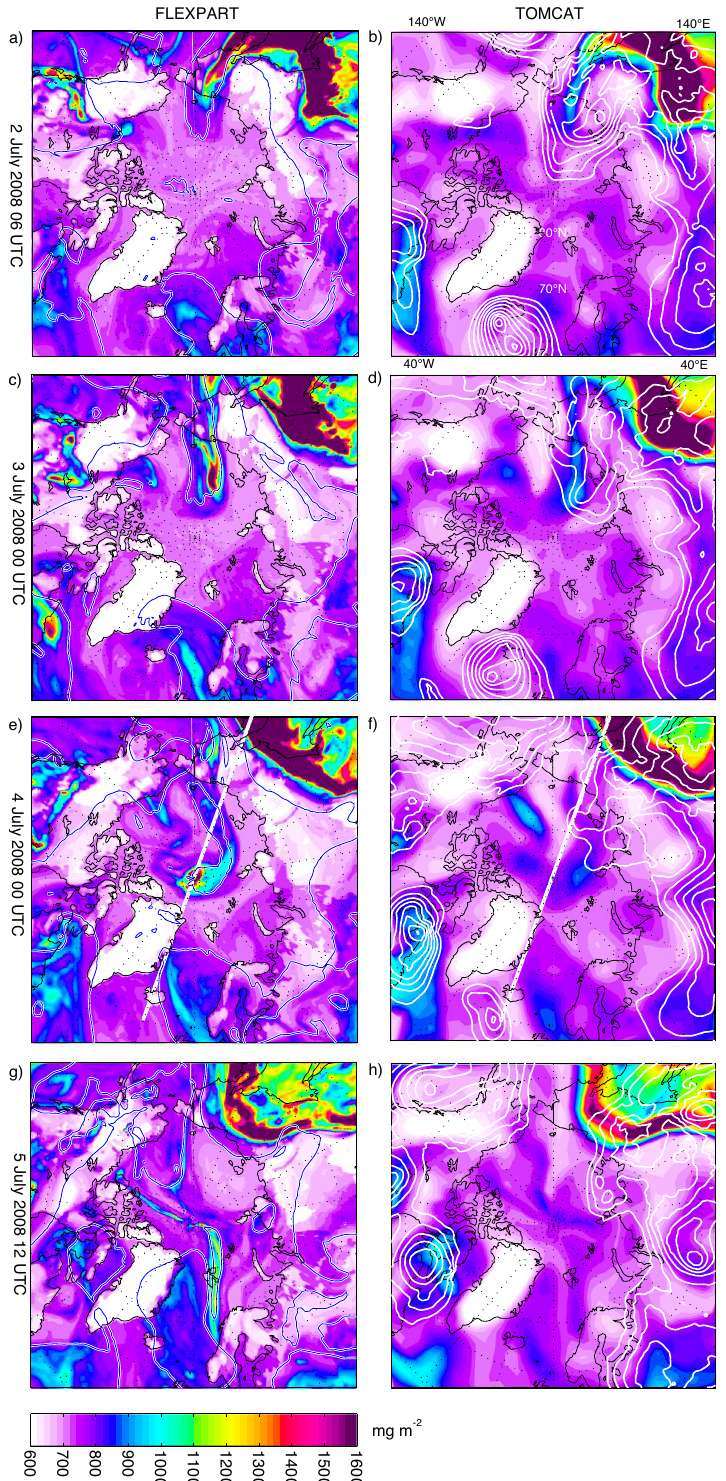
Fig. 2. Total column CO (shading, mgm − 2 ) during the period 2 July 2008 06:00UTC to 5 July 2008 12:00UTC in the FLEXPART model simulation (left column) and the TOMCAT model simulation (right column). The meteorological situation is denoted by the dynamic tropopause in the left column (2pvu isoline at the 320K isentrope, blue line) and sea-level pressure in the right column (white contours, 1010 to 970hPa at 3hPa interval) using ECMWF analysis data. Thick white line denotes the transect shown in Fig.